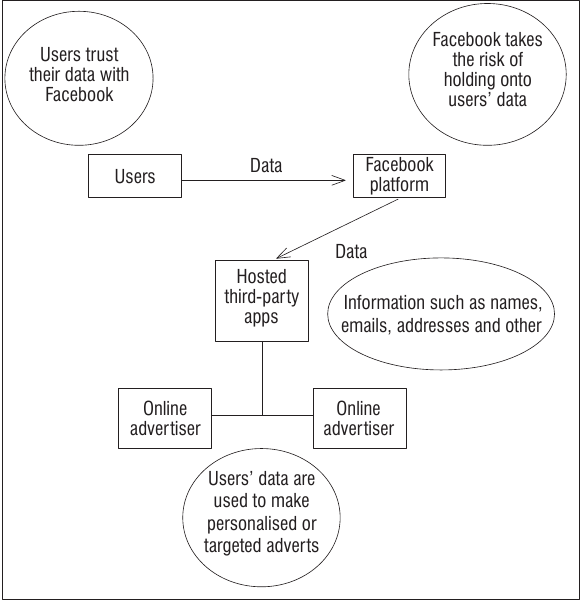
Figure 1: Information privacy model.